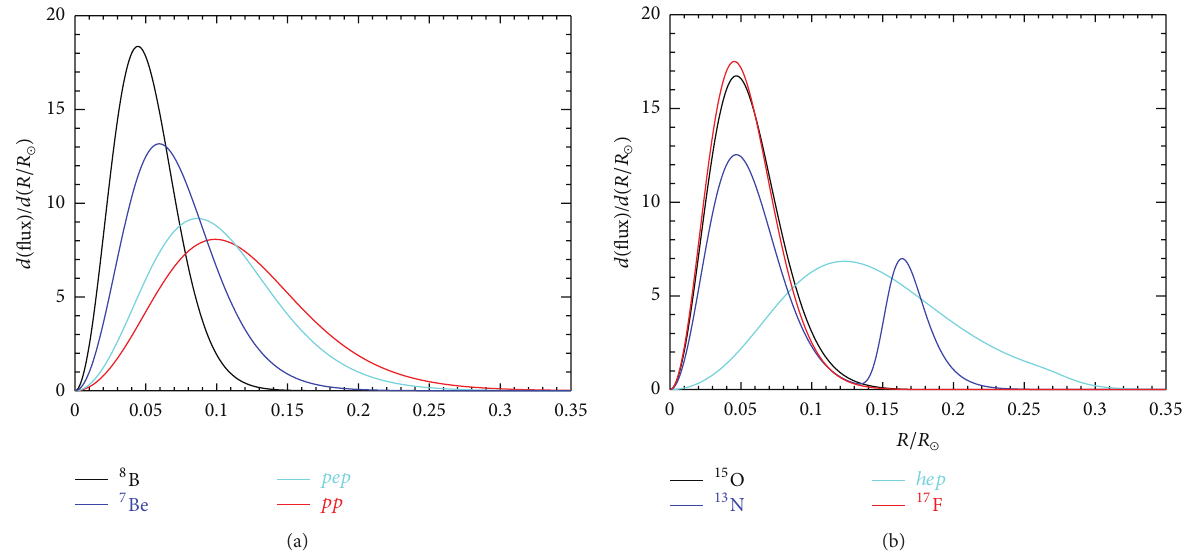
Figure 2: Normalized production profiles of solar neutrinos as a function of solar